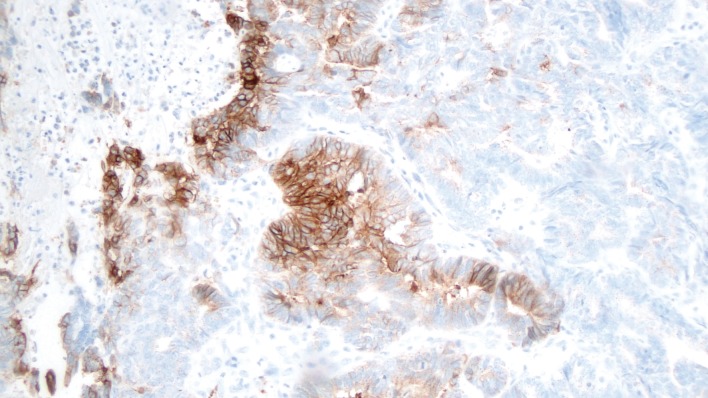
Endometrioid carcinoma with membranous expression of L1CAM.